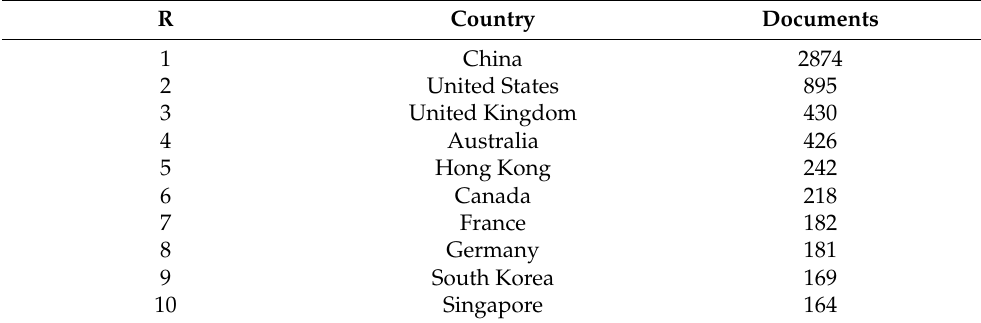
Table 5 points out the contributions of institutions to the highest-ranked AI journals